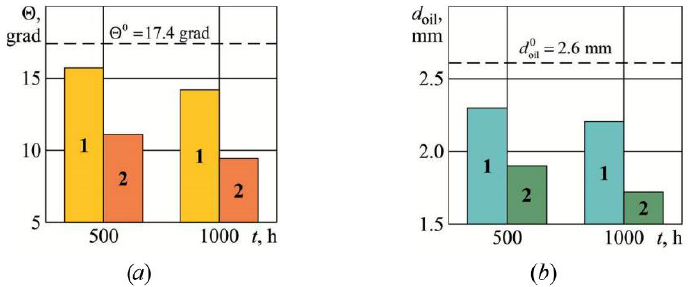
Figure 8. Dynamics of changes in the structural characteristics of engine oil Shell Gadinia AL 40: ( a ) — wetting angle, θ , grad; ( b ) — oil layer thickness, d oil , mm ( Θ 0 , 𝑑 oil0 — wetting angle and thickness of the oil layer before the start of the experiment).